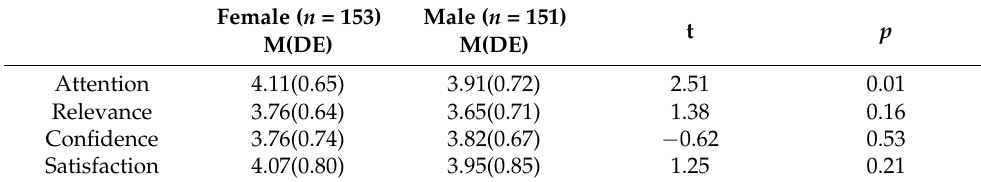
Table 2. Table of Student’s t -test results by